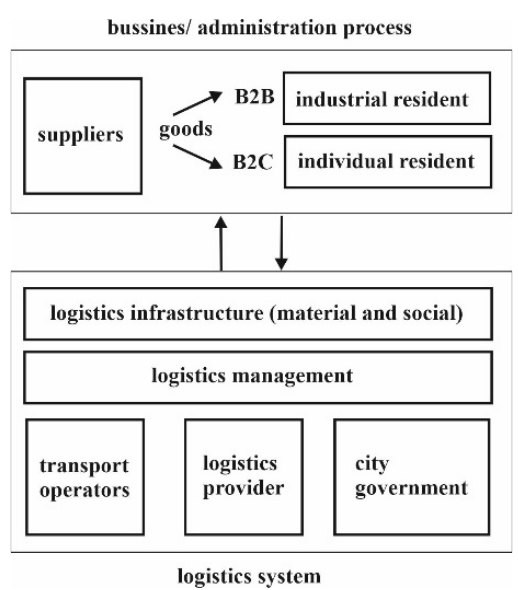
Figure 2. Key components of the City Logistics System. Source: Own study.